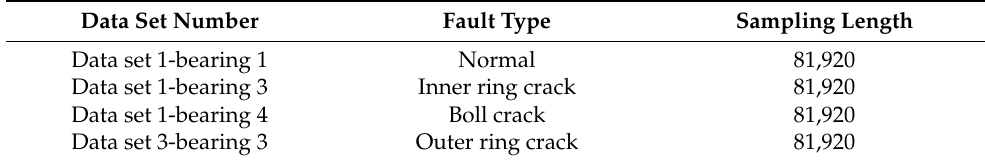
Figure 4. Bearing test bench and structure diagram. Table 1. Bearing failure category